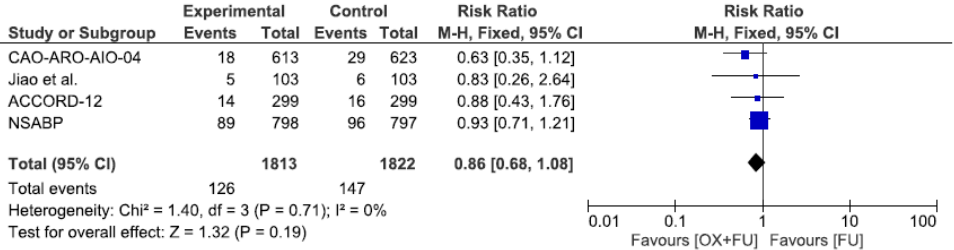
Figure 4. Forest plot of risk ratio for local recurrence.